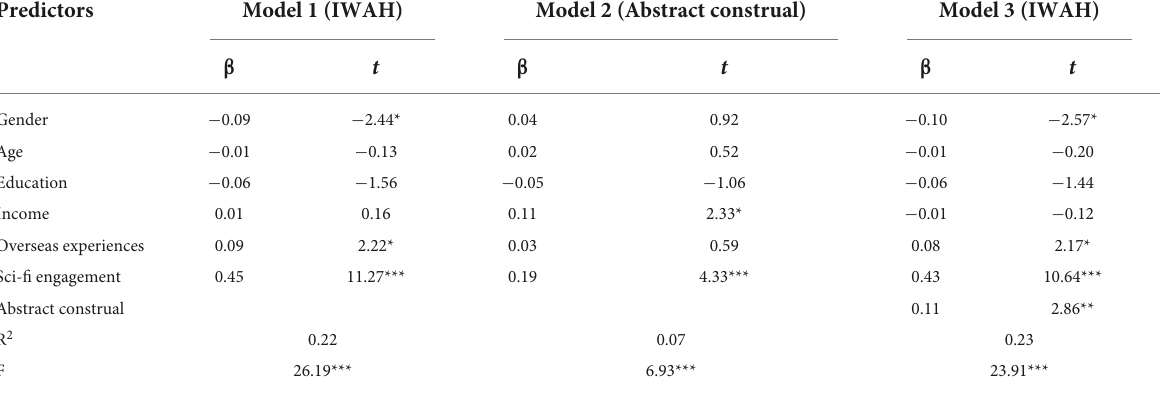
TABLE 4 Testing the mediation effect of abstract construal between sci-fi engagement and identification with all humanity (IWAH). Predictors Model 1 (IWAH) Model 2 (Abstract construal)